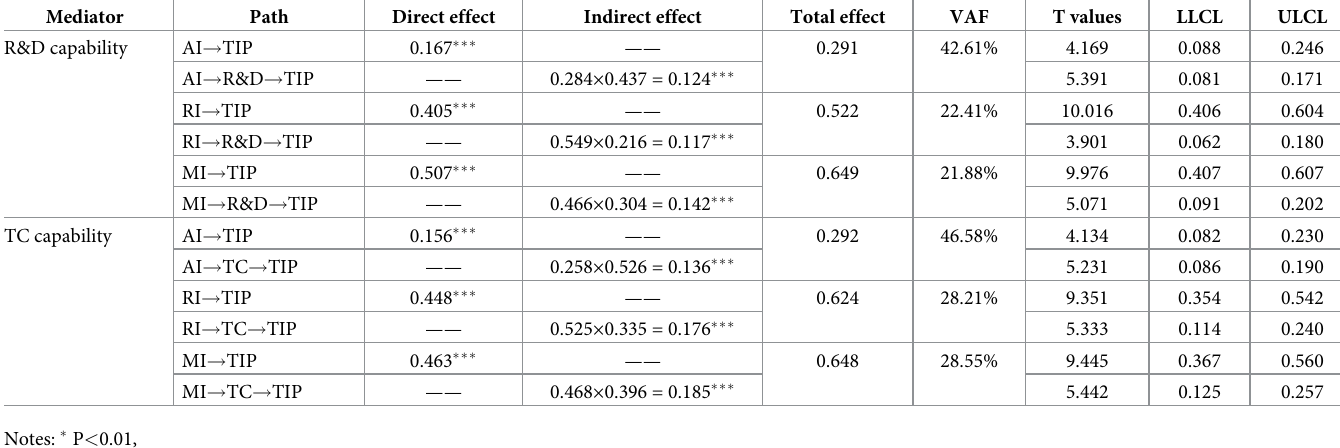
Table 5. Mediation analysis by Bootstrap and result of VAF.